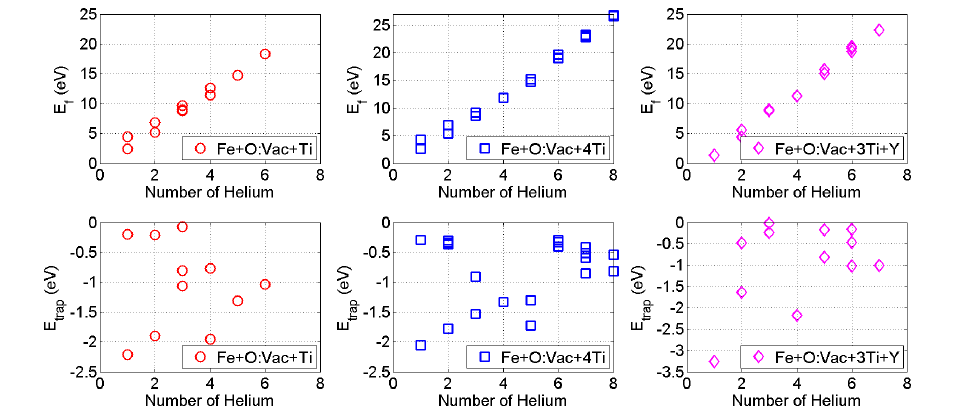
Figure 5. Formation energy and He trapping energy variation with n in He n X clusters: X = Fe + O:Vac + Ti (red circles), X = Fe + O:Vac + 4Ti (blue squares), and X = Fe + O:Vac + 3Ti + Y (magenta diamonds).